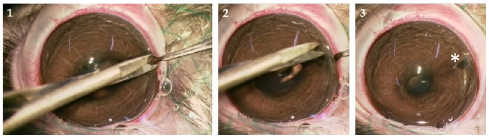
Figure 1. Iris biopsy. A small incision was made in the cornea, iris was grasped with small forceps, pulled from the anterior chamber (panel 1), and a 1 mm × 2 mm biopsy cut (panel 2). The cut in the cornea sealed without suturing; the asterisk (* panel 3) marks the iridectomy site.